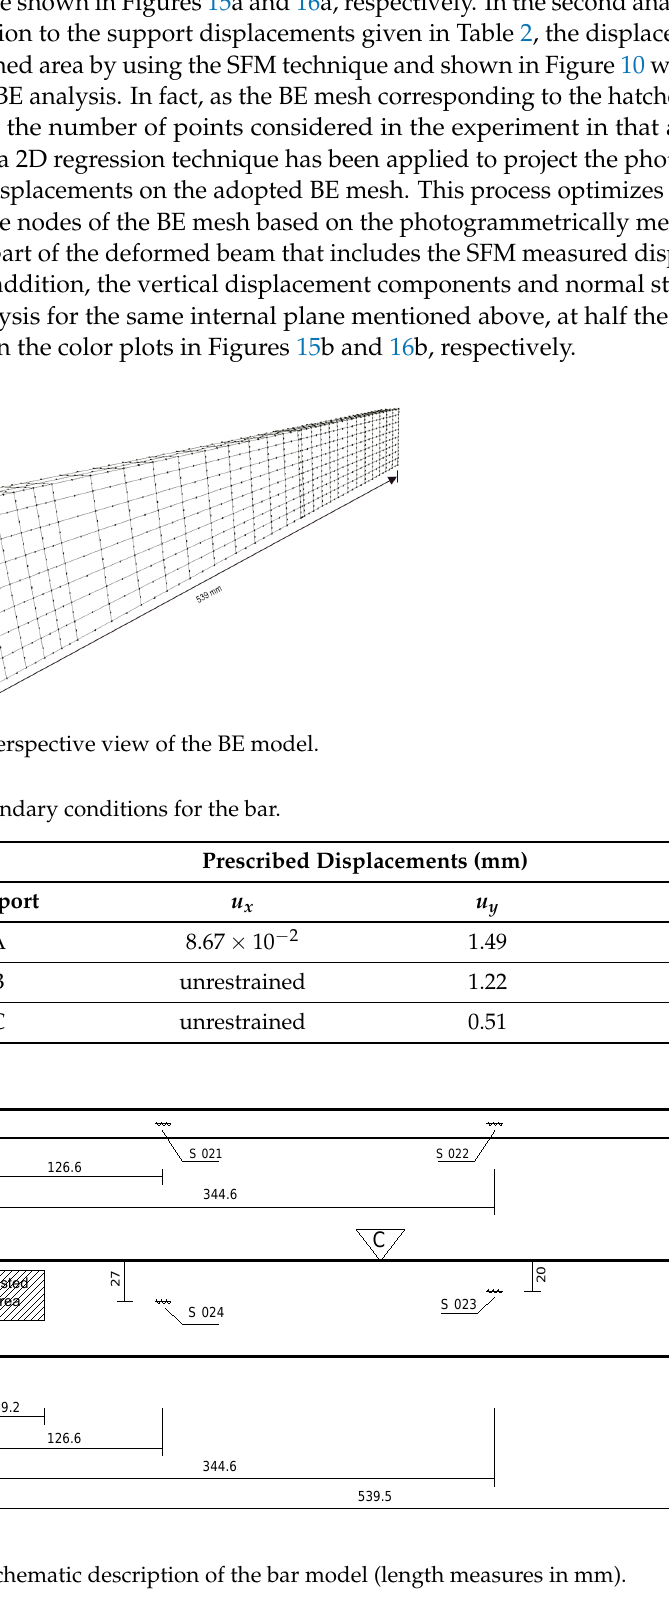
Figure 13. Schematic description of the bar model (length measures in